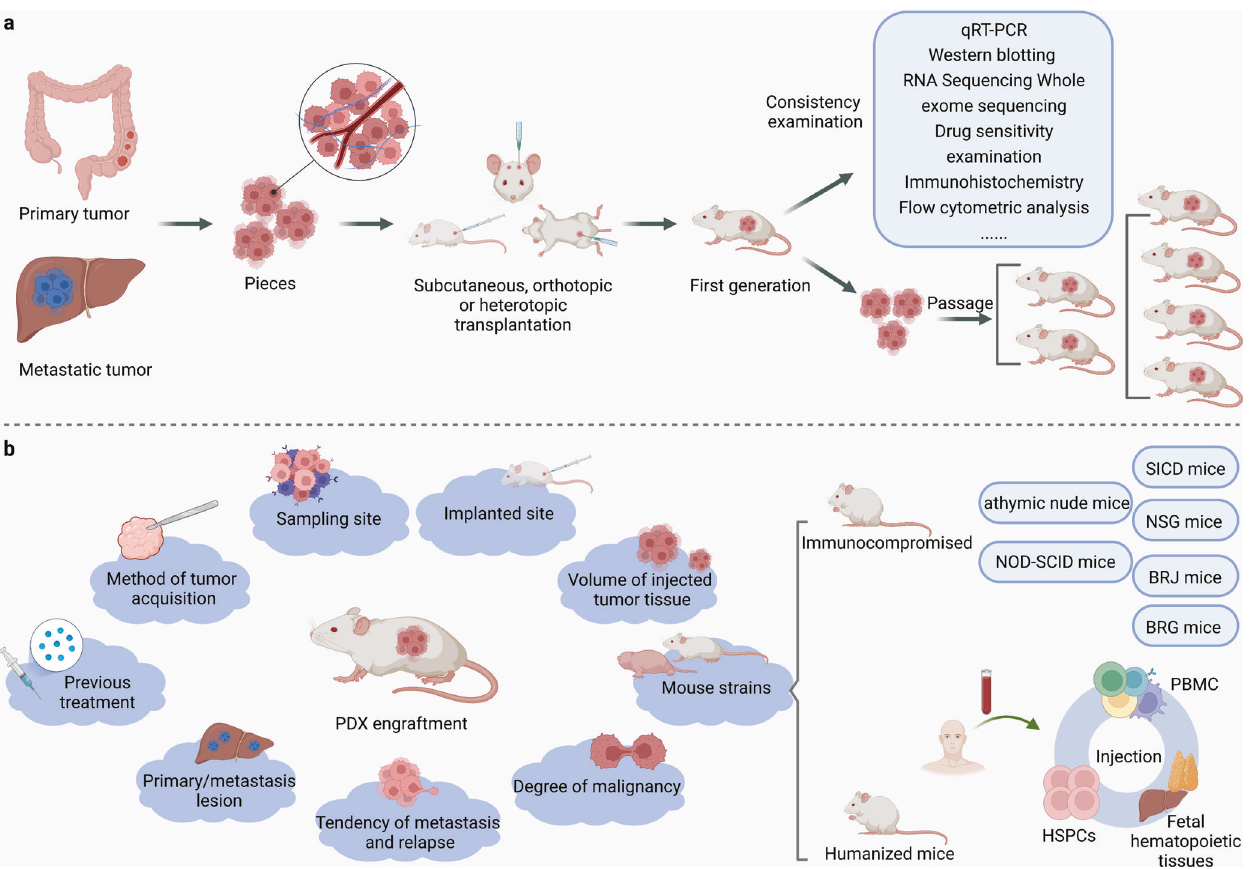
Fig. 3 The establishment of PDX. a Showing the establishment process of PDX. b Showing the factors affecting the engraftment rate and the categories of PDX